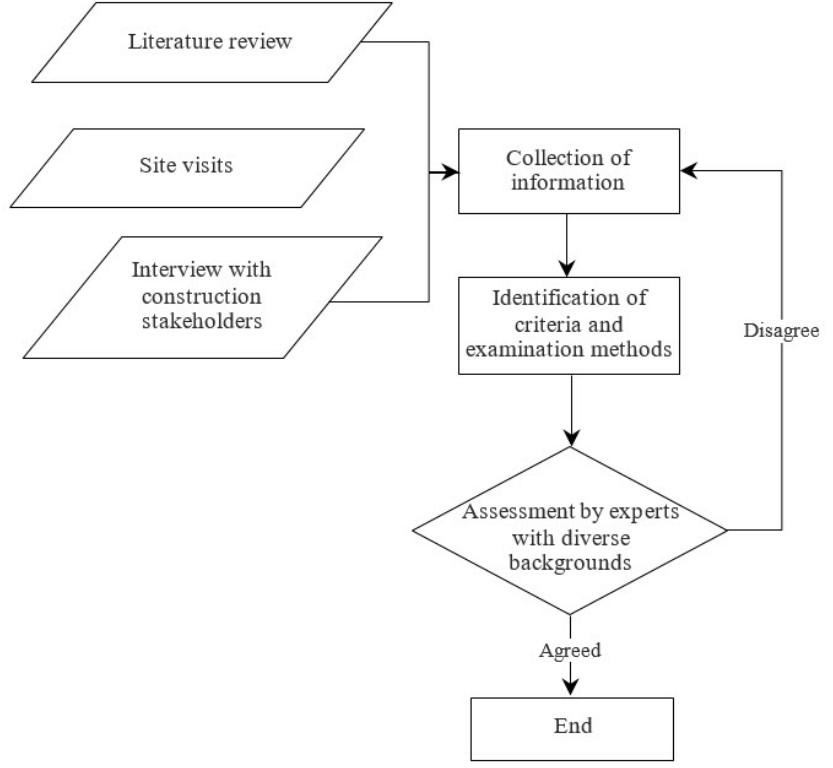
Figure 3. Identifying attributes and examination method.